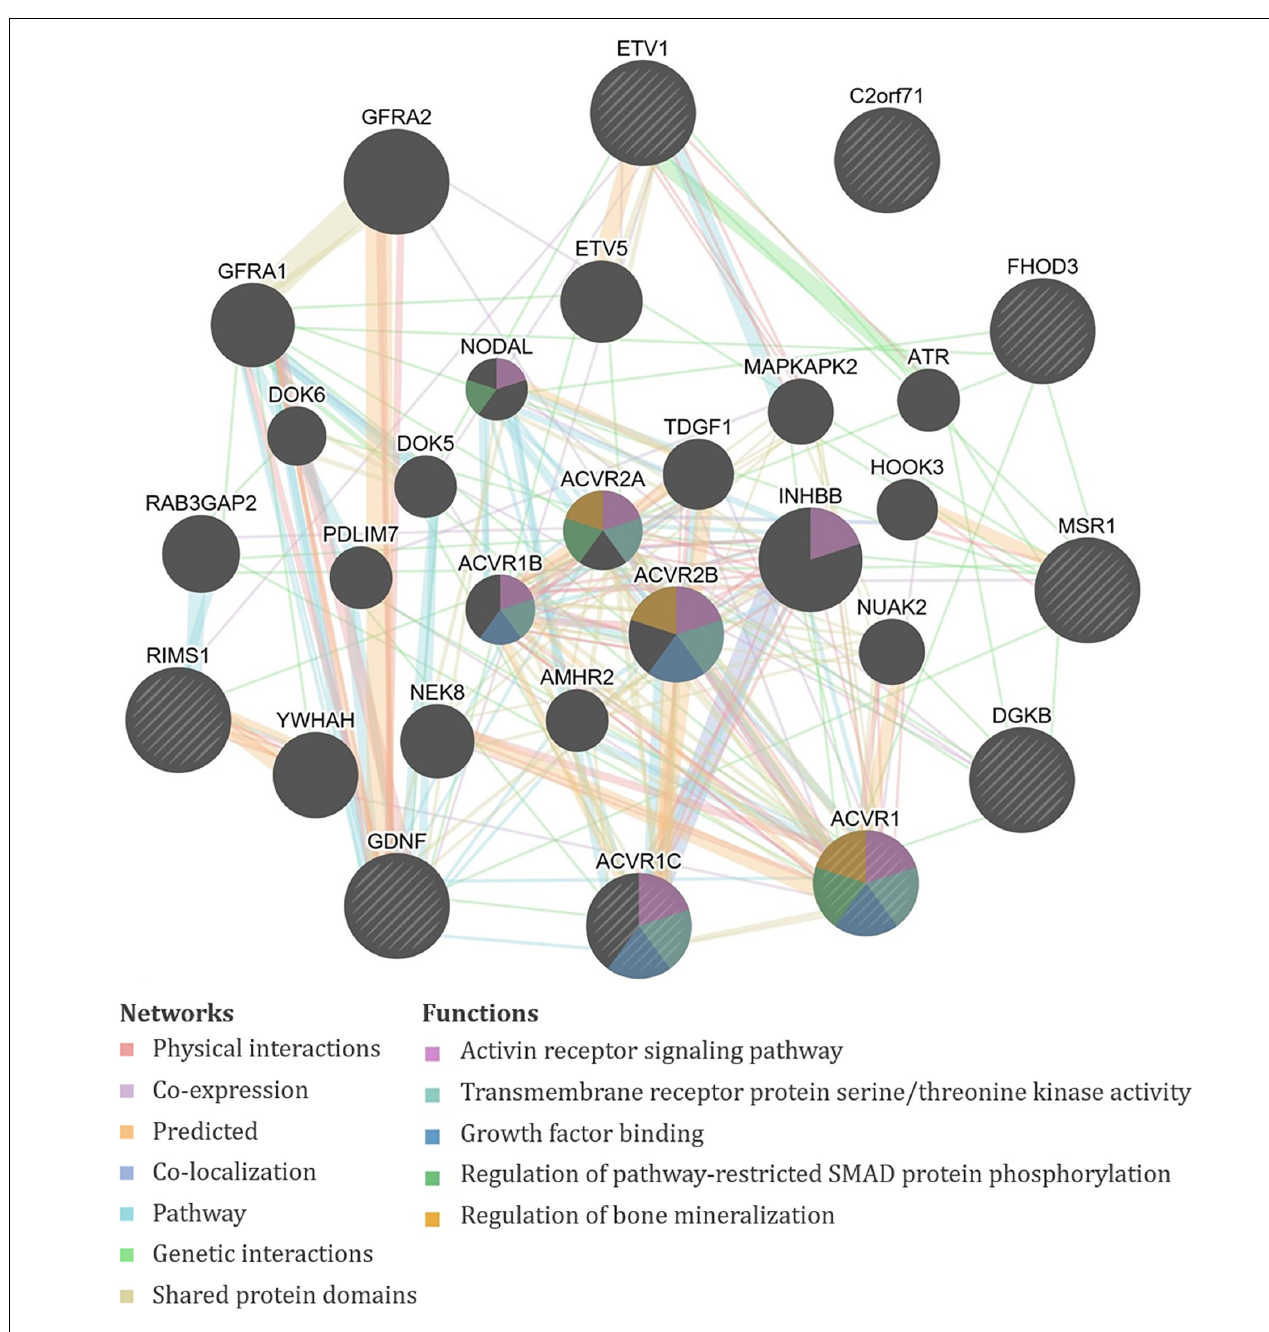
FIGURE 3 | GeneMANIA output for the products of genes proximal to the significant single-nucleotide polymorphisms (SNPs) associated with exposure-adjusted 1,6-diaminohexane (HDA) levels in plasma and urine. Query genes have black circles with white-striped lines, the networks are shown with the colored lines between genes, and the shading on the circles shows the